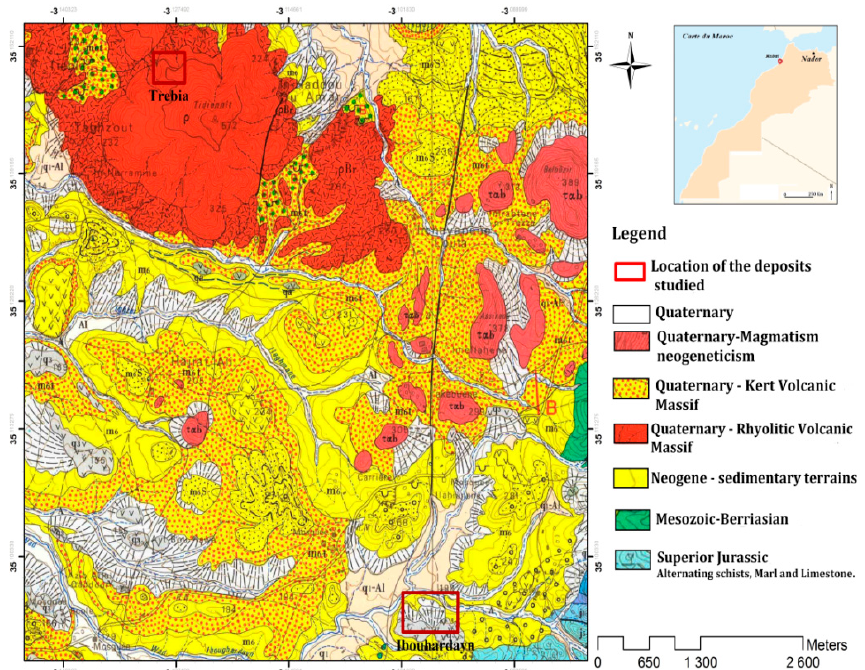
Figure 13. Geological map of the deposits studied.